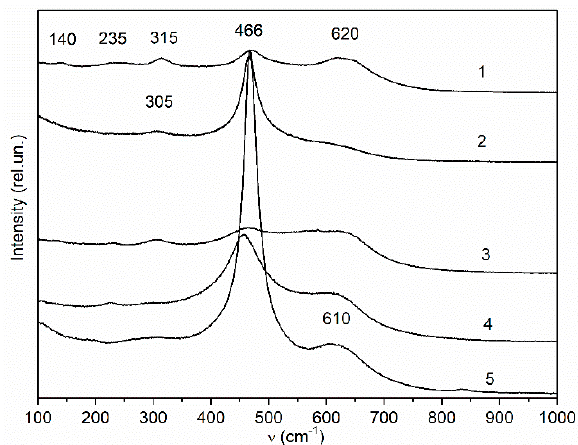
Figure 3. Raman spectra of Ce x Zr 1 − x O 2 supports and Ni-Ce x Zr 1 − x -op catalysts: 1—Ce 0.3 Zr 0.7 , 2—Ce 0.5 Zr 0.5 , 3—Ni-Ce 0.5 Zr 0.5 -op, 4—Ni-Ce 0.7 Zr 0.3 -op, and 5—Ce 0.7 Zr 0.3 .